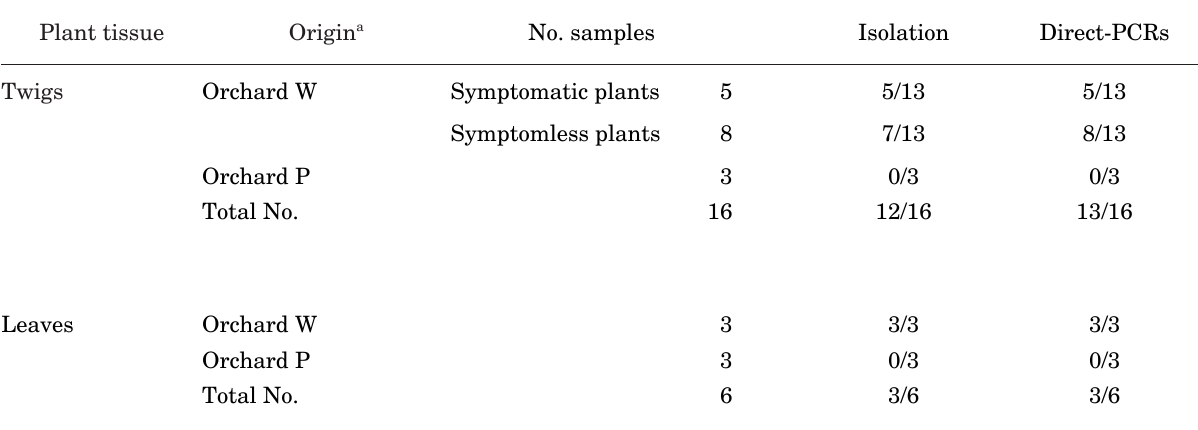
Table 3. Pseudomonas syringae pv. actinidiae (Psa) detection by isolation and direct-PCR in symptomless twigs col- lected in 2011 from orchard W and orchard P. The number of positive samples divided by the total number of tested samples is reported for isolation and